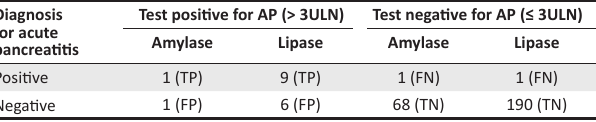
TABLE 1: Amylase and lipase results for acute pancreatitis testing obtained from Tygerberg Hospital, South Africa, 1–31 December 2018. Test positive for AP (> 3ULN) Diagnosis for acute pancreatitis